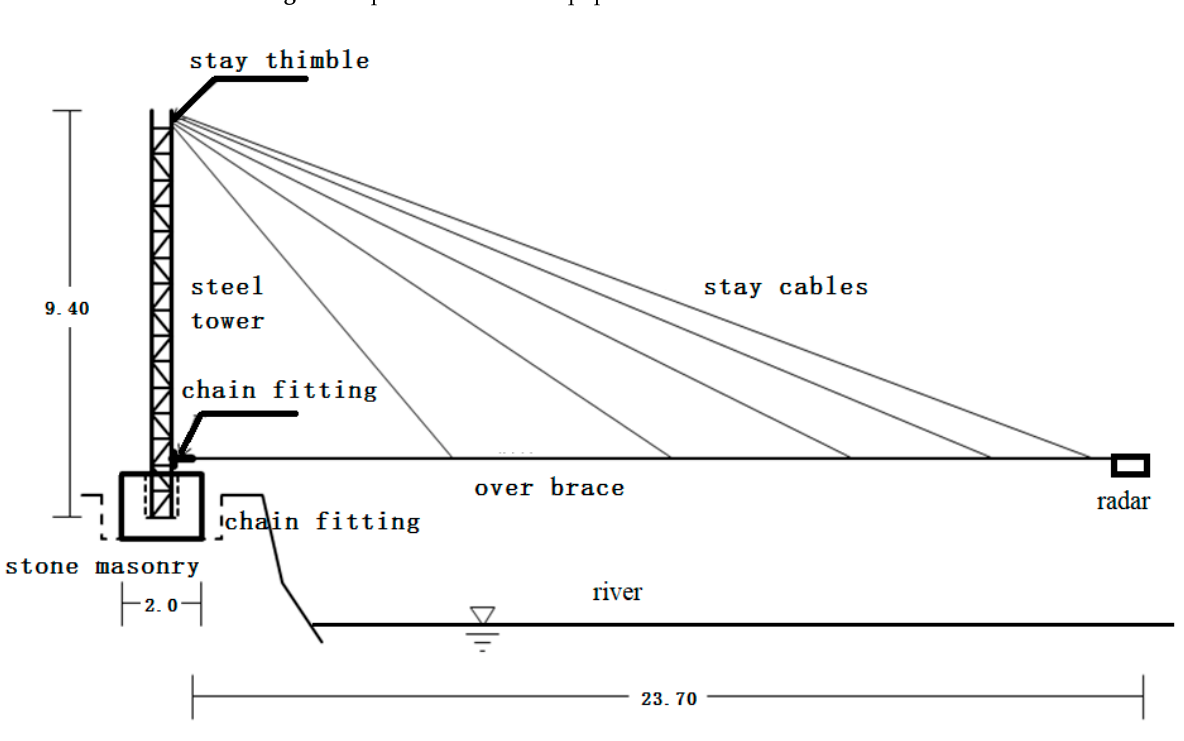
Figure 3. Installation drawing of equipment.